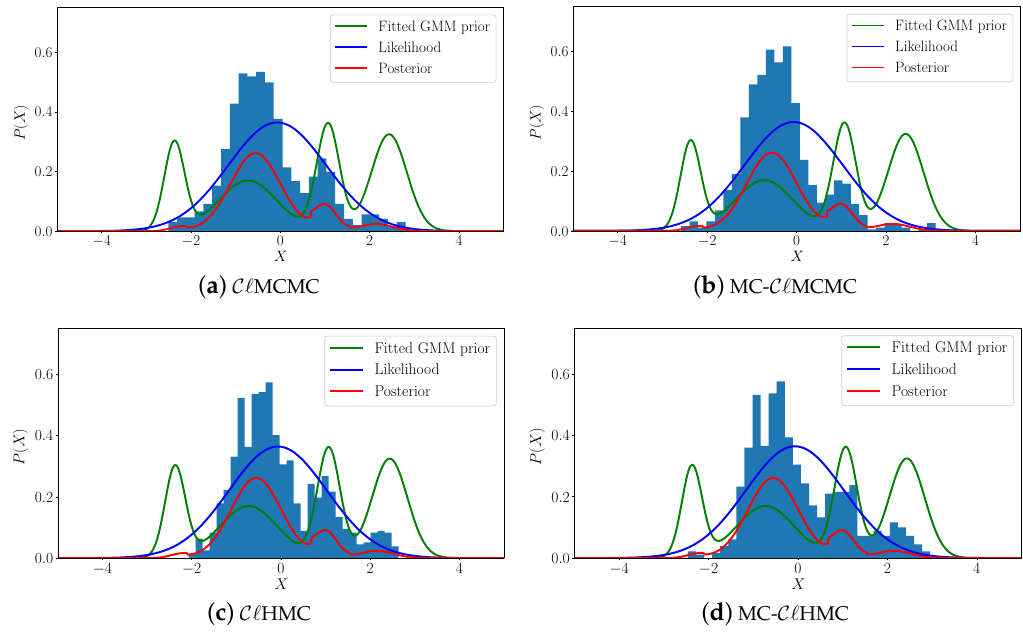
(cid:96) MCMC ( a ), MC- (cid:96) MCMC C C